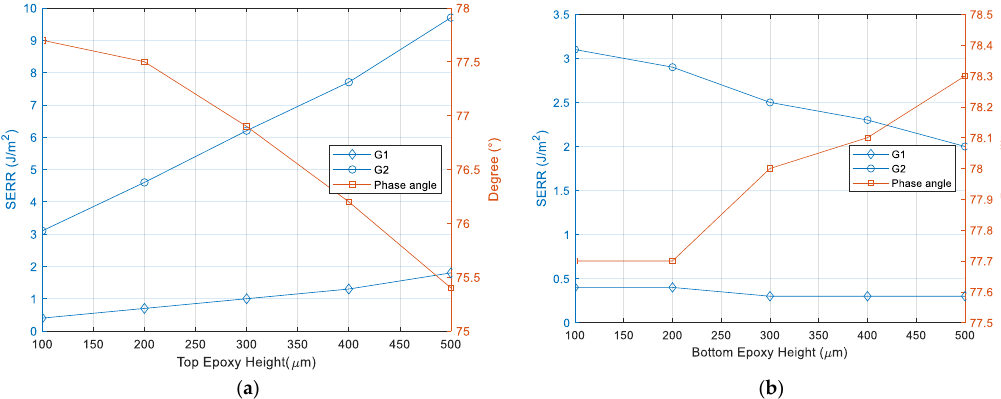
Figure 9. Dimension parameters for parametric analysis.